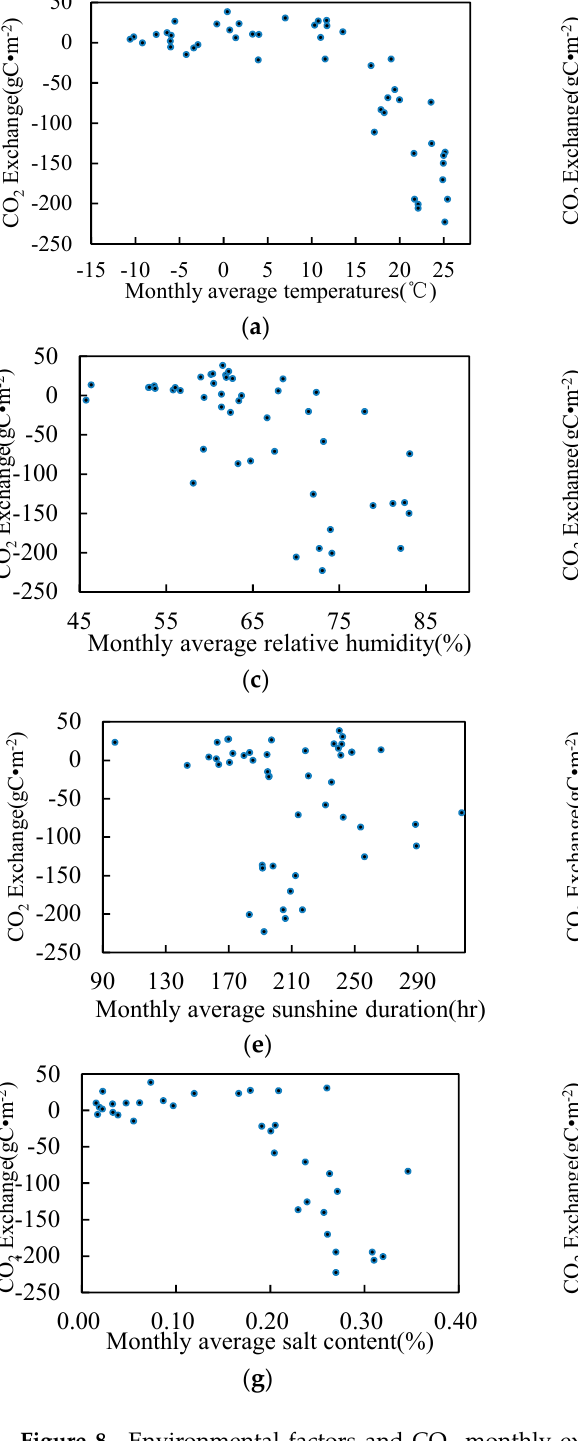
Figure 8. Environmental factors and CO 2 monthly exchange. ( a ) Temperature; ( b )Precipitation; ( c ) Relative humidity; ( d ) Wind speed; ( e ) Sunshine duration; ( f ) Water table level; ( g ) Salt content; ( h ) Soil temperature.